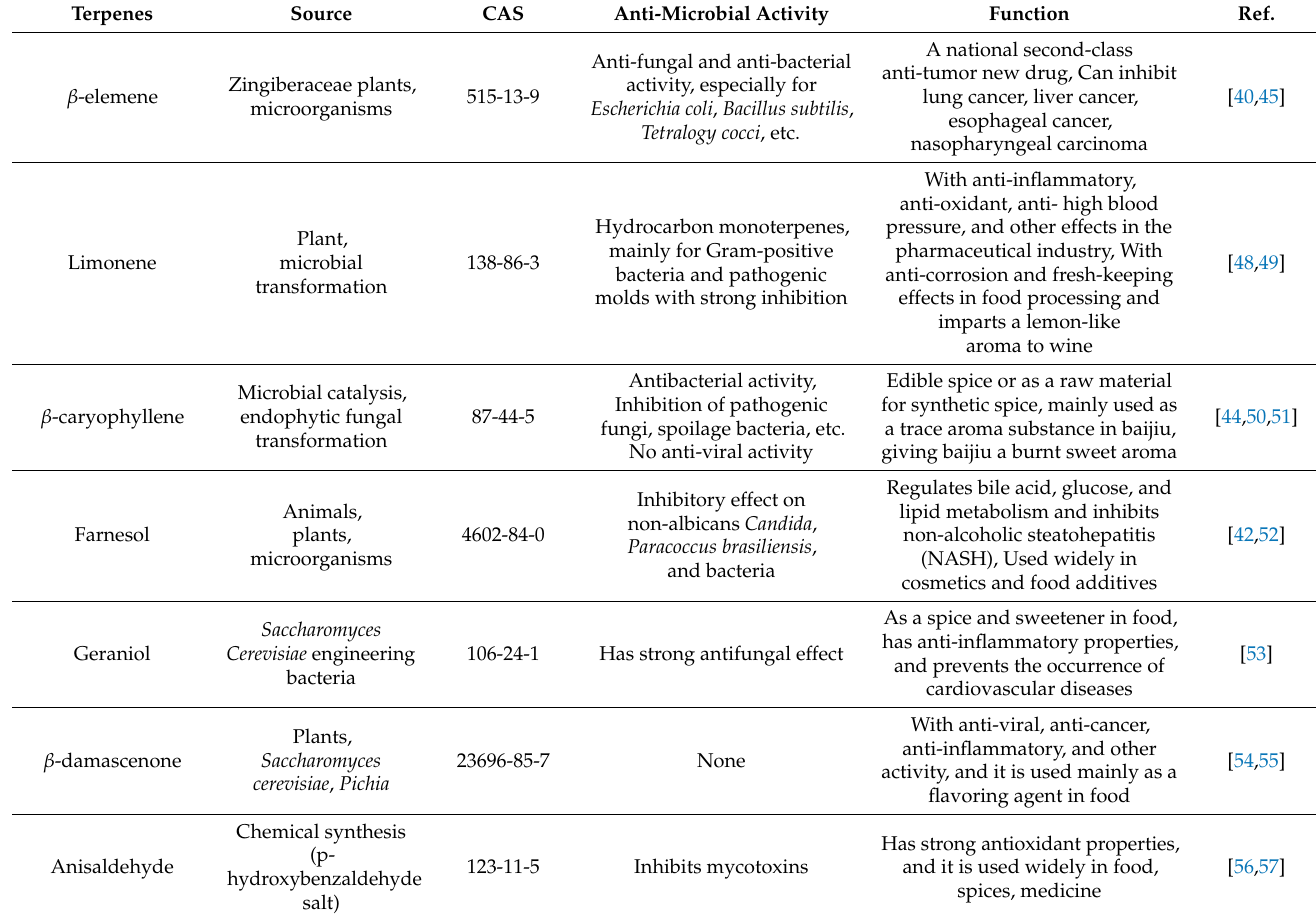
Table 1. Common terpenes in Chinese baijiu and their antimicrobial